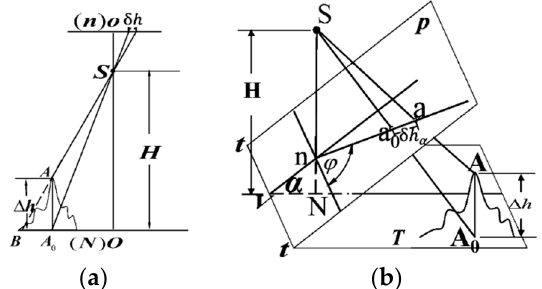
Figure 1. Schematic diagram of the projection error. ( a ) Vertical photography image; ( b ) Image with rotation angle.